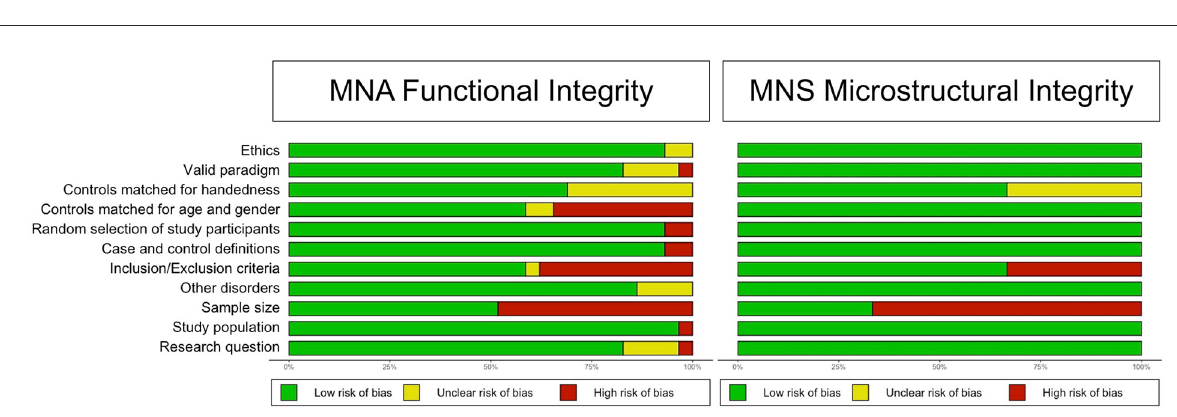
the main outcome (functional integrity of MNA) and 3 for the secondary outcome (microstructural integrity of